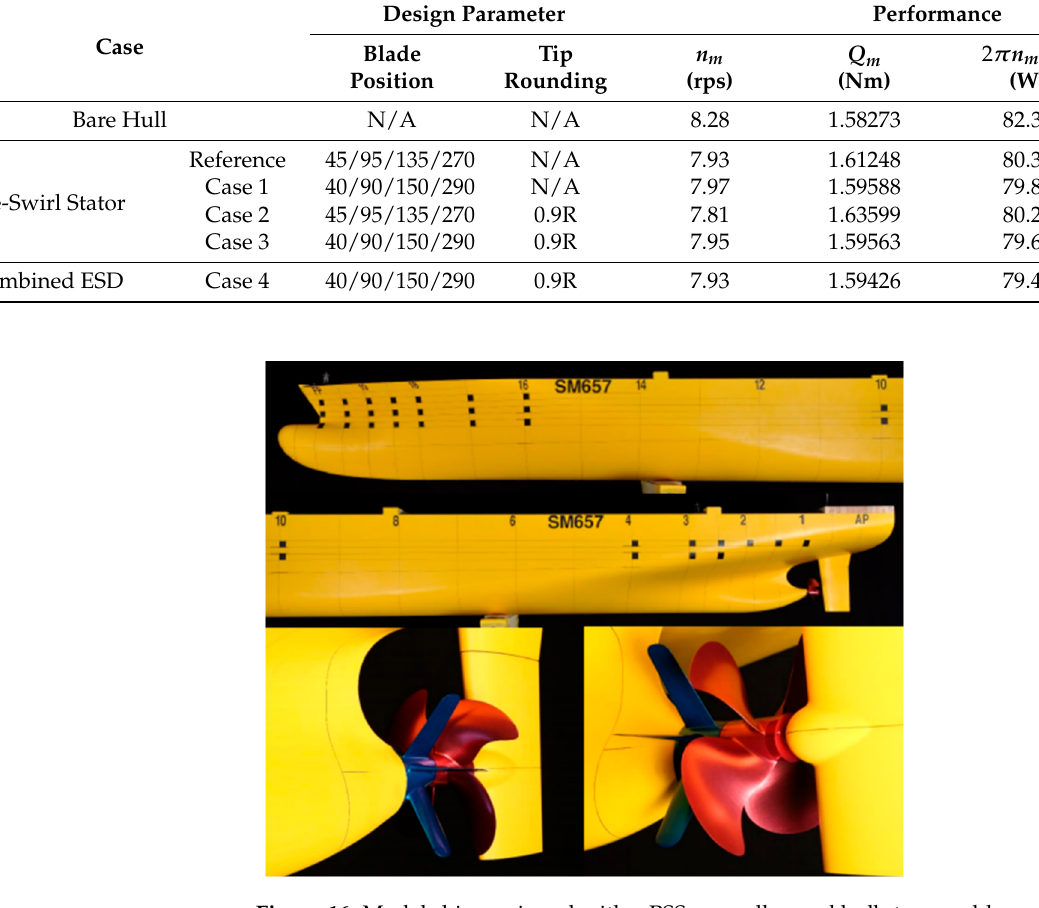
Figure 16. Model ship equipped with a PSS, propeller, and bulb ‐ type rudder.